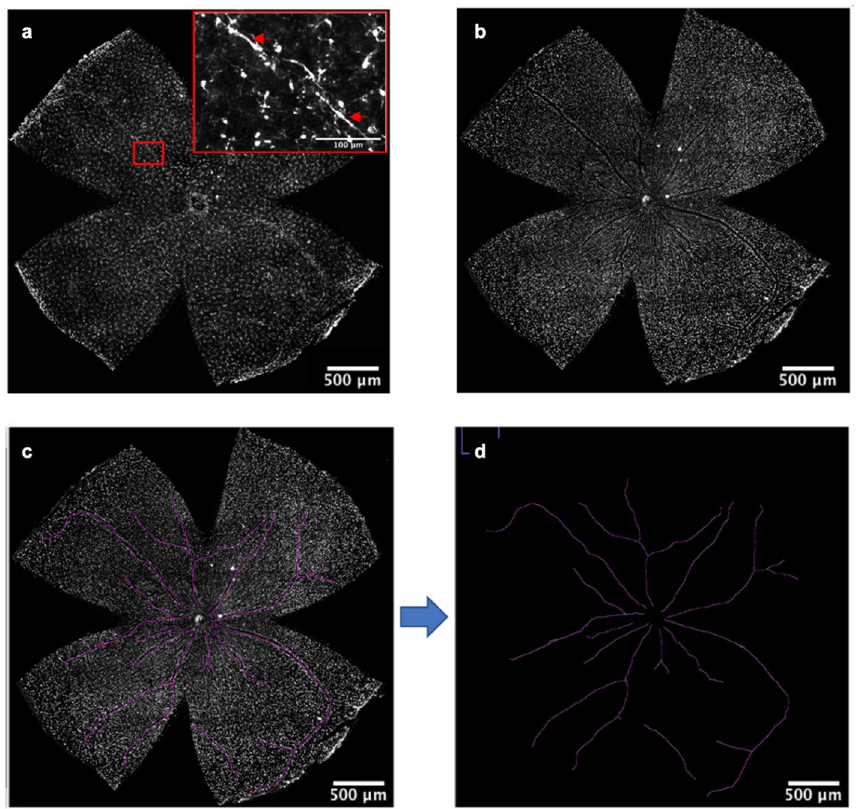
Figure 8. Perivascular Area Analysis Process. ( a ) and ( b ) display the same sample imaged in the Iba-1 ( a ) or RBPMS ( b ) channel. The vessel may be distinguishable in ( a ) as shown by the enlarged insert and red arrows. ( b ) shows that the vessel is more clearly visible. ( c ) shows the retinal vasculature having been traced onto the image. ( d ) shows an image of just the retinal vasculature. Scale bars represent 500 μm in all images whilst the enlarged section in ( a ) shows 100